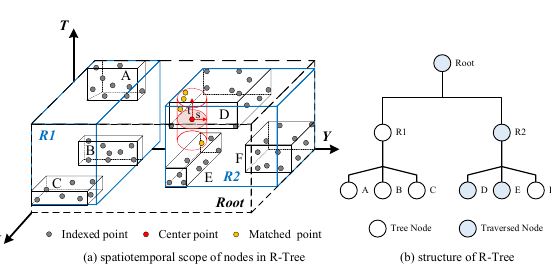
Figure 3. R-tree with Sort-Tile-Recursive (STR) algorithm for spatiotemporal point pair queries